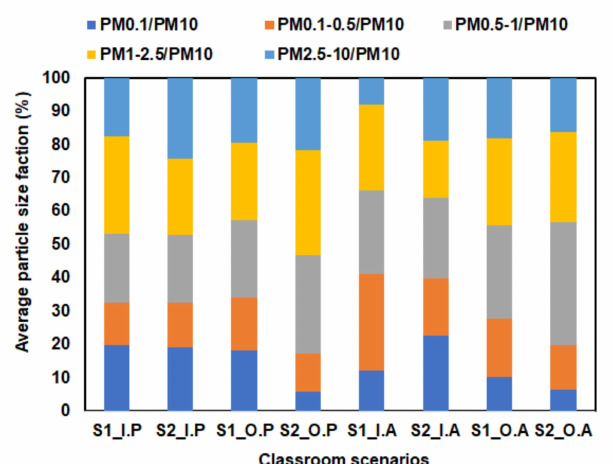
Figure 2. Mass-size distribution of indoor and outdoor airborne particles (n = 80, I.P and O.P denote Indoor and Outdoor in the Presence of children while I.A and O.A are Indoor and Outdoor in the Absence of children,